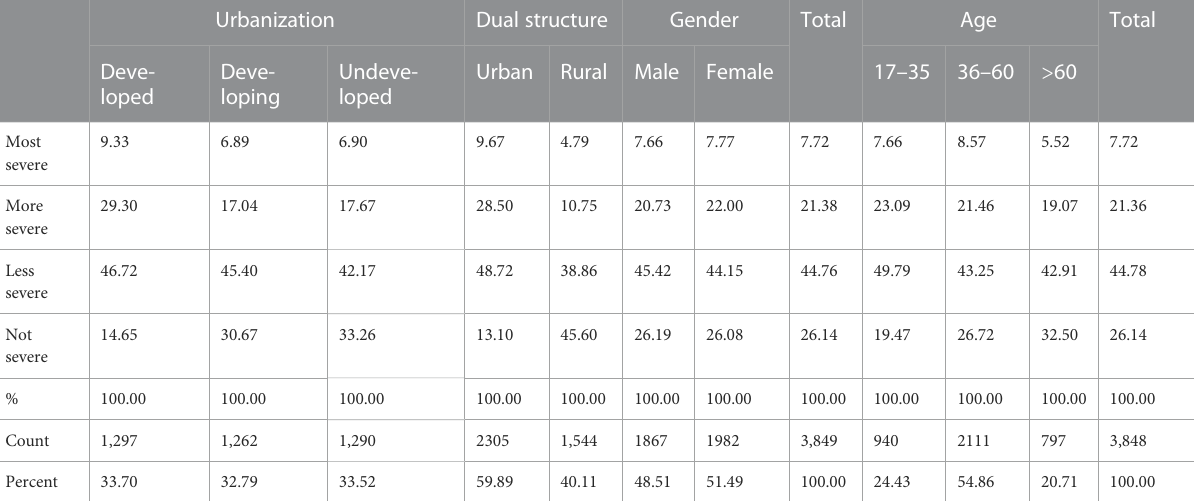
TABLE 2 Responses recorded for AQP and their corresponding percentages according to various